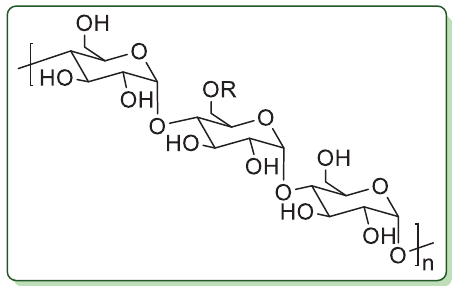
Figure 2. Chemical structure of starch.